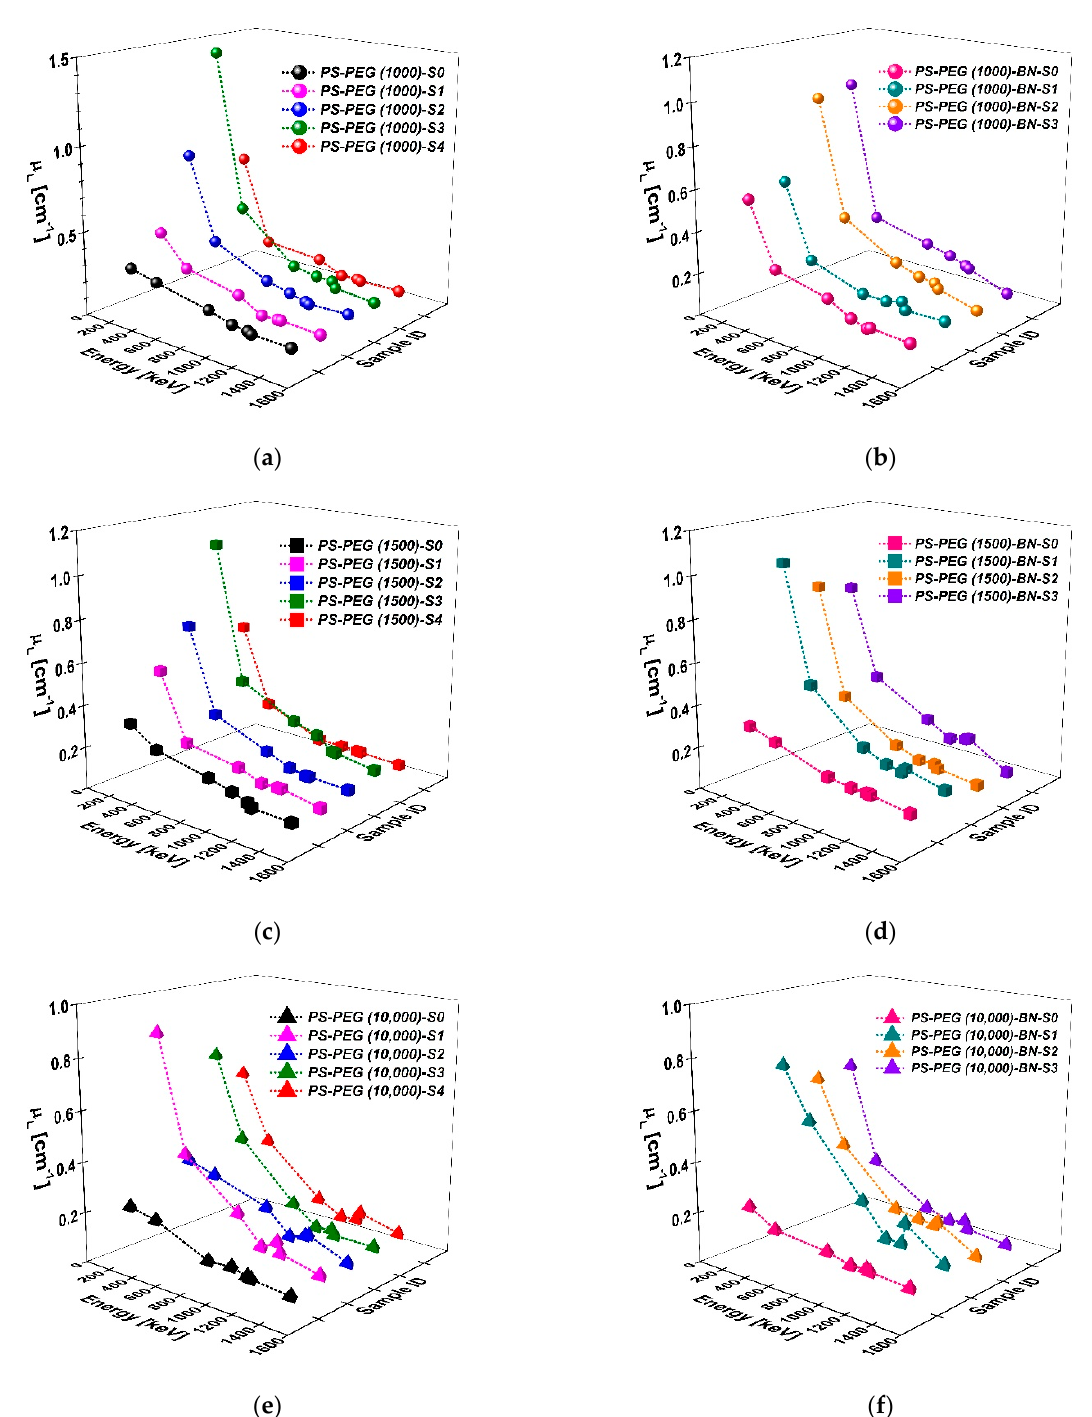
Figure 6. The LACs values of the PbO doped the crosslinked PS-b-PEG block copolymers and the PbO doped the PS-b-PEG-BN nanocomposite materials at different gamma radiation energies (from 121.782 keV to 1408.006 keV) of 152 Eu : ( a ) PS-PEG (1000)-S0,S1,S2,S3,S4; ( b ) PS-PEG (1000)-BN-S0,S1,S2,S3; ( c ) PS-PEG (1500)-S0,S1,S2,S3,S4; ( d ) PS-PEG (1500)-BN-S0,S1,S2,S3; ( e ) PS-PEG (10,000)-S0,S1,S2,S3,S4; ( f ) PS-PEG (10,000)-BN-S0,S1,S2,S3.